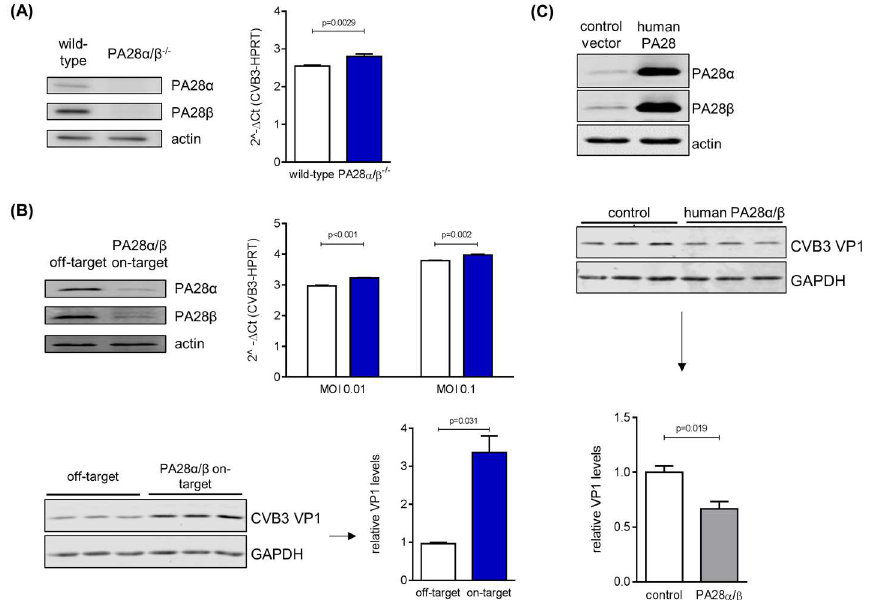
Fig 3. Effect of PA28 α / β on coxsackieviral replication. (A) eCMs were isolatedfrom wild-typeas well as PA28 α / β − / − mice and cell lysates were subjectedto Western blottingof PA28 α and PA28 β (top). Cells were infected with CVB3 at MOI 0.1 for 16 hours and CVB3 mRNA was determined by real-time qPCR (bottom). Data are means + SEM of n = 4 independentexperiments. (B) HeLa cells were transfected with siRNA targeting PA28 α / β for 72 hours and protein levels were assessedby Western blotting of PA28 α and PA28 β (top left). siRNA-treated HeLa cells were infected with CVB3 at indicatedMOIs for 16 hours and relative expressionof CVB3 mRNA was determined by real-time qPCR (bottom, left graph, means + SEM of n = 2). In addition,lysates of CVB3-infected HeLa cells (MOI 0.01) pre-treatedwith siRNA were analyzedby Western blottingof CVB3 VP1 structural protein and GAPDH (top right). Densitometricanalysisof VP1 levels, normalized to GAPDH, is depictedas relativeintensitiesin comparisonto infected HeLa cells pre-treatedwith off-target siRNA (means + SEM, n = 3). (C) HeLa cells were transiently transfected with humanPA28 α / β .Cell lysates were subjectedto Western blotting to confirm recombinant PA28 α / β expression. Following24 hours PA28 α / β transfection, cells were infected with CVB3 at MOI 0.1 for 16 hours. VP1 and GAPDH levels were determined by Western blotting and quantified by densitometry of the immune